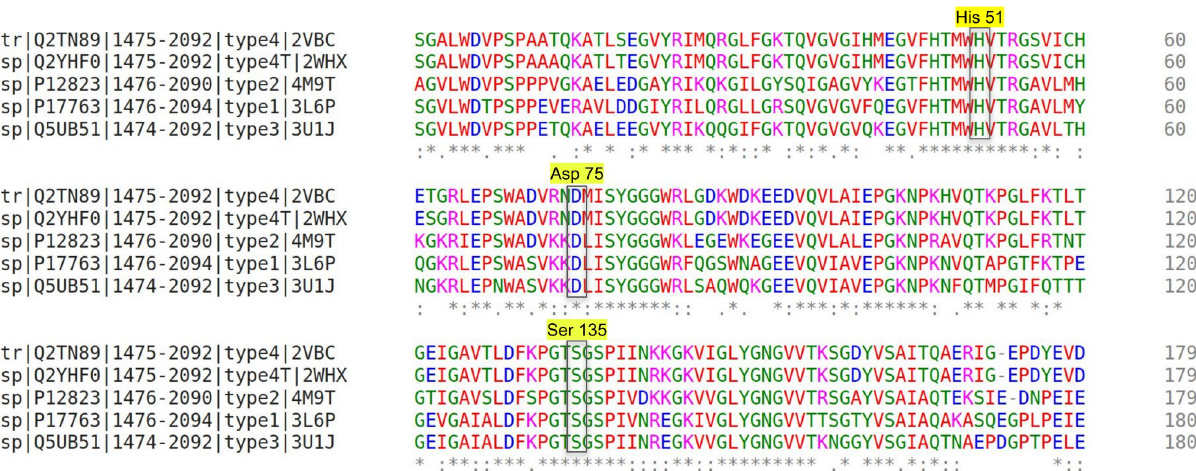
Fig 1. Multiple sequence alignment of DENV protease from five serotypes with highlighted active site residues. Vide S1 Fig for percent identity matrix.